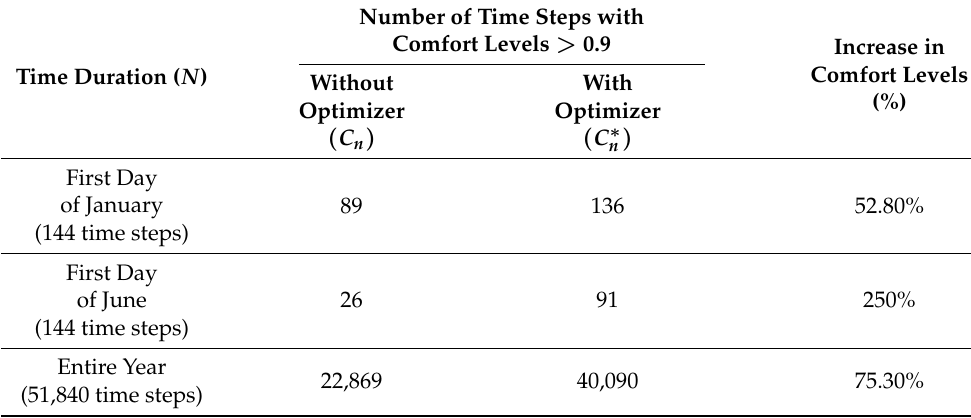
Table 3. Number of time steps recorded with high comfort level